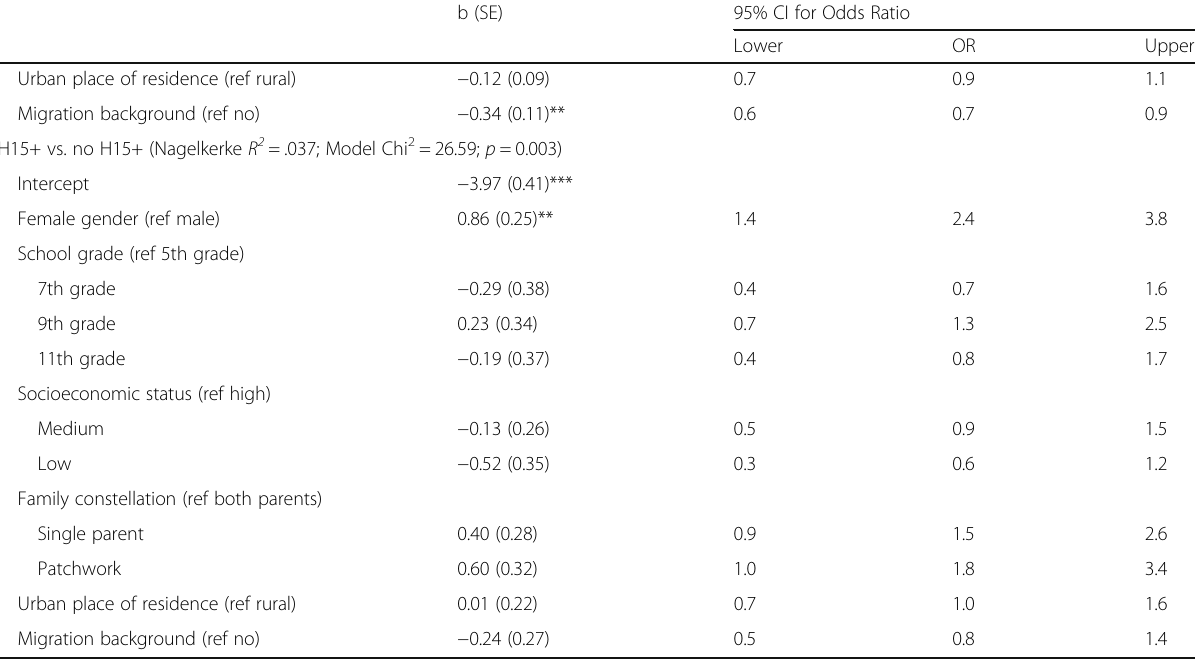
Table 4 Logistic regression analyses of sociodemographic associations with headache type